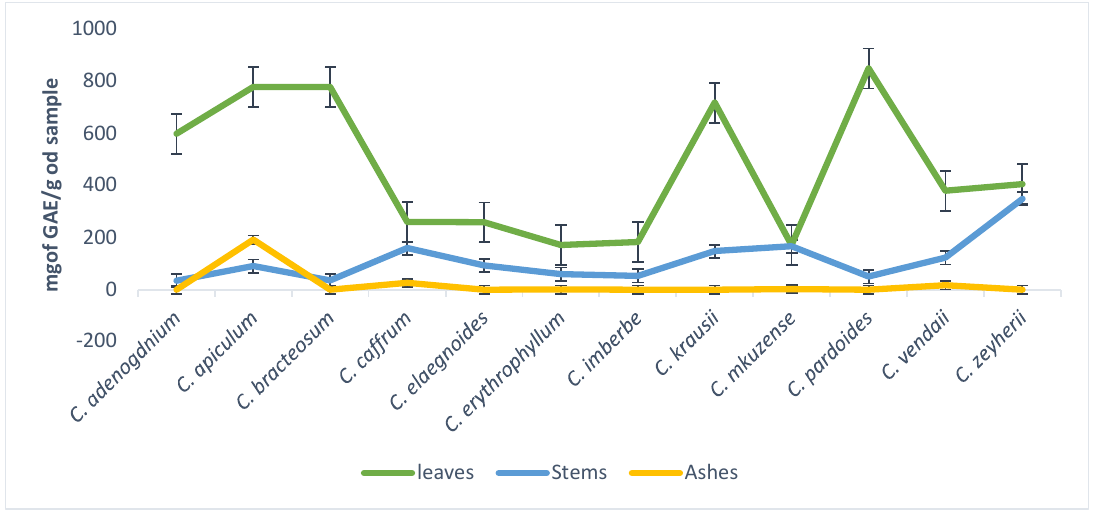
Figure 2. Total tannins content concentrations of the 70% aqueous acetone extracts of twelve Combretum species. Most of the leaves had the highest flavonoids concentration when compared to the stems apart from C. kraussii , C. apiculatum, C. pardoides , and C. adenogdnium. Interestingly, ashes of C. apiculatum, C. elaegnoides, and C. vendae had the highest concentrations of the flavonoids when compared with other species of Combretum (Figure 3).